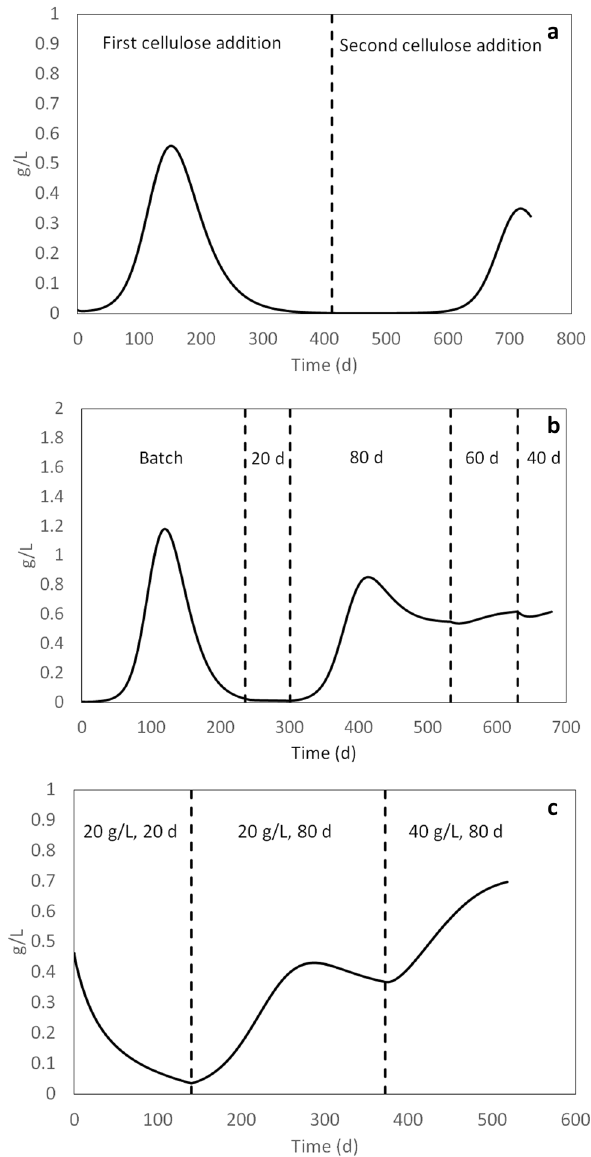
Fig. 7 Calculated biomass concentration (X) according to the model in Run A ( a ), Run B ( b ), Run C ( c